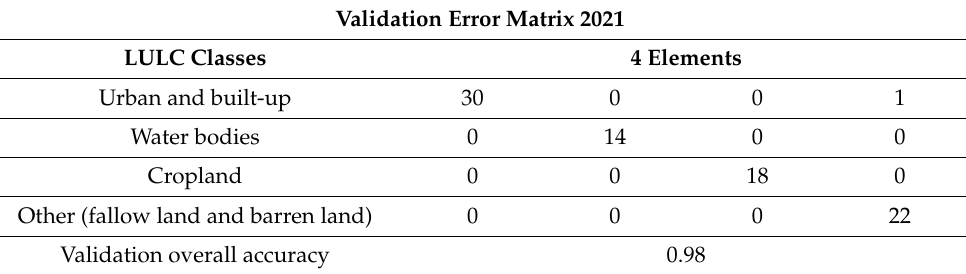
Table 2. Evaluation of the accuracy assessment of the LULC classification for the year 2021.